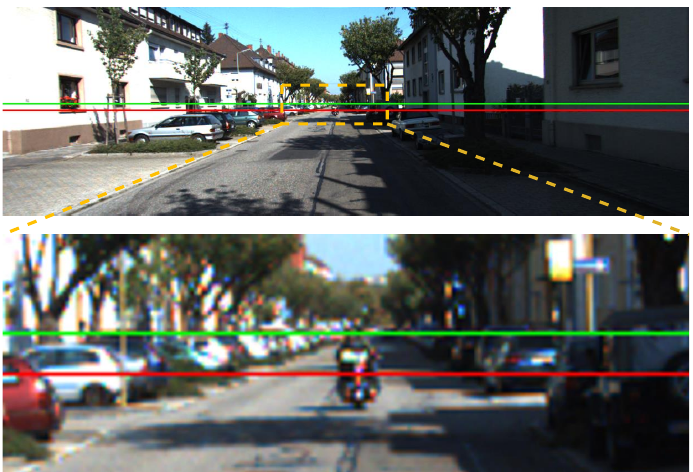
Figure 9. Visualization of vanishing lines. The red and green horizontal lines are vanishing lines converted from fixed and dynamic ground plane normals, respectively. The ( bottom ) image is a zoom-in image of orange rectangular areas from the ( top ) image. The green line is obviously a more accurate estimation of the vanishing